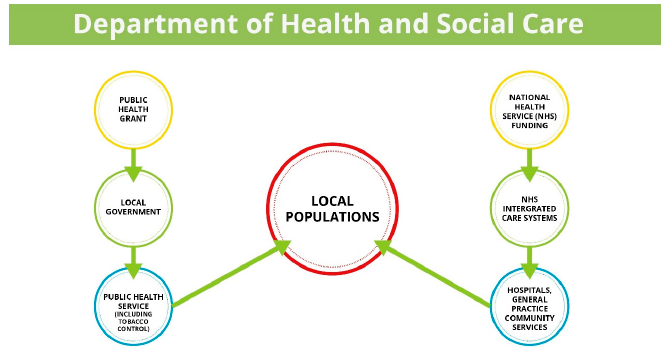
Figure 1. Funding flow from the Department of Health and Social Care to the NHS and Local Government in England.